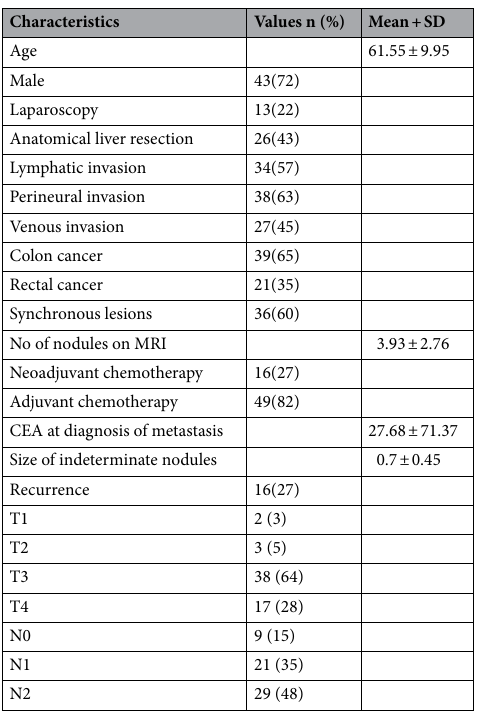
Table 1. Patient characteristics. MRI magnetic resonance imaging, CEA carcinoembryonic antigen.